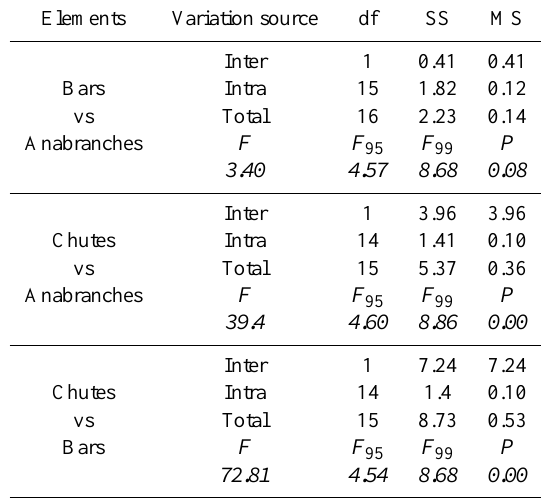
Table 2. ANOVA tests on the surface grain-size distributions of the three kinds of morpho-sedimentary element. df is the number of degrees of freedom, SS the sum of square and MS the mean square. P is the probability to get this value F from samples ex- tracted from a single population. The null hypothesis is that there is no difference in the mean values of the grain-size distributions. Chutes are clearly different from anabranches and bars ( F > F 99 ), whereas anabranches and bars cannot be considered as two different populations ( F < F 95